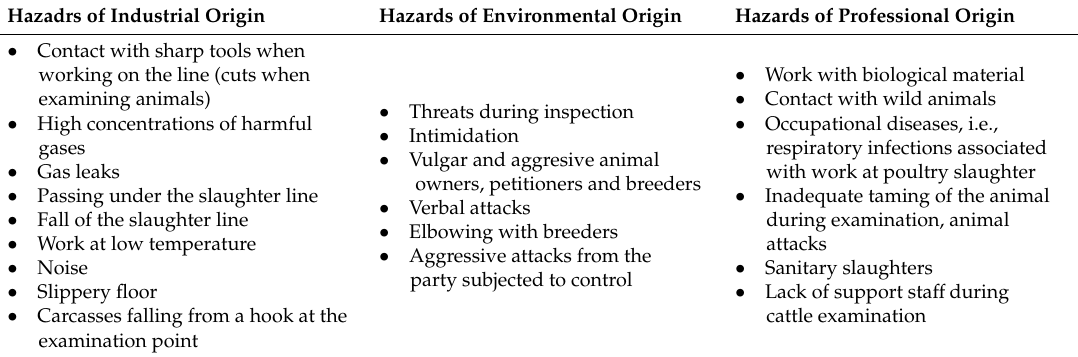
Hazards encountered by Veterinary Food Inspectors (VFIs) while fulfilling their professional